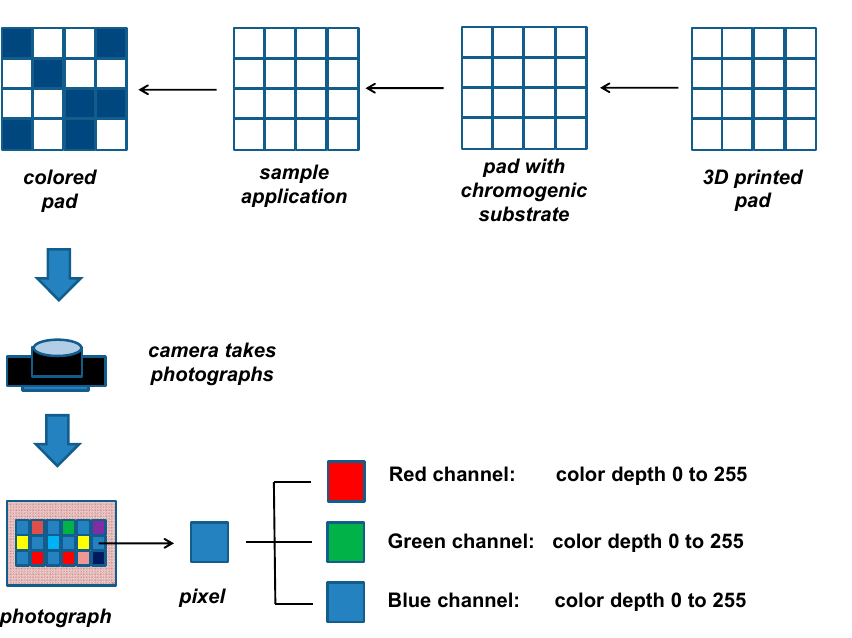
Figure 2. General principle of the colorimetric assay of cholinesterase activity.